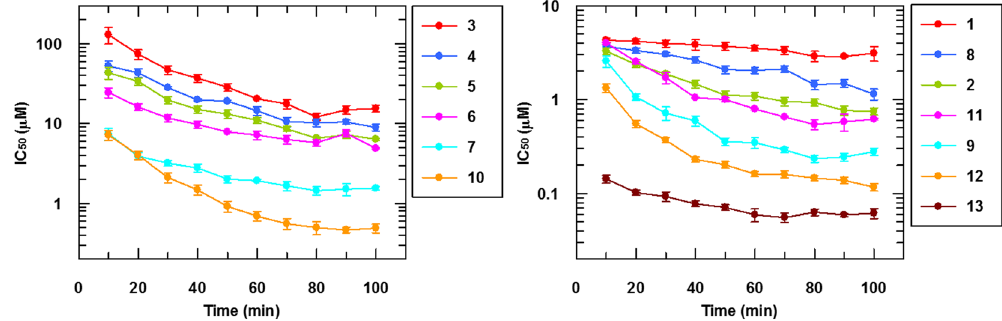
Figure 3. Time dependence of enzyme assay IC 50 values. IC 50 values of BTZs and BOZs as a function of time. All of the determined IC 50 values decrease with the reaction